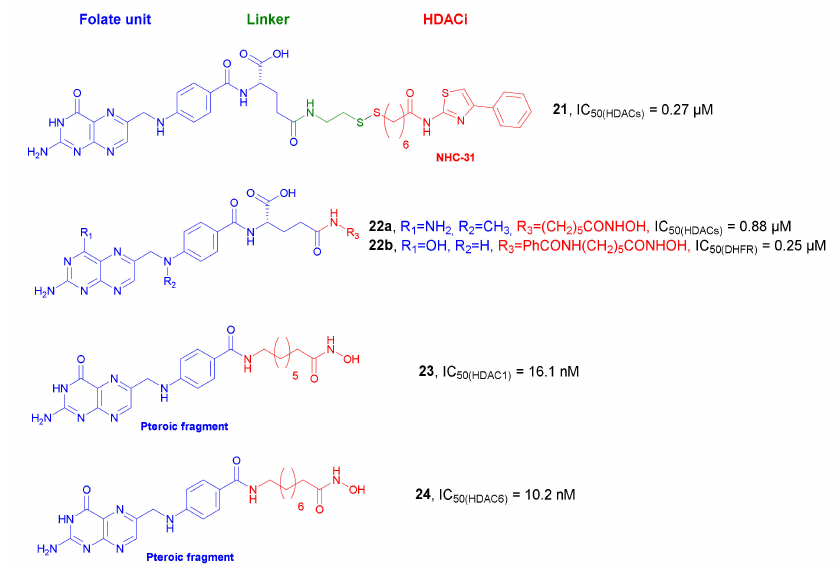
Figure 12. Chemical structure of HDACi -folic acid conjugates 21 – 24